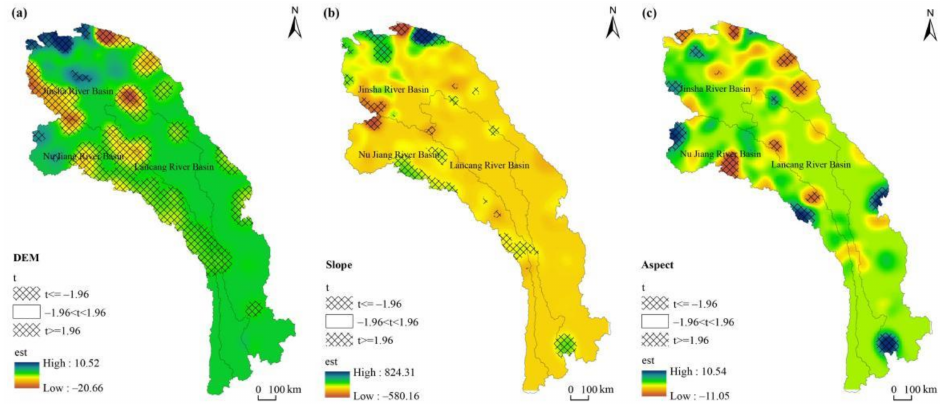
Figure 8. Spatial distribution maps of regression coefficients and significances for all independent variables. ( a – c ) are the spatial distribution maps of the local regression coefficients and the signifi- cances for all independent variables, e.g., ( a ) elevation, ( b ) slope and ( c ) aspect